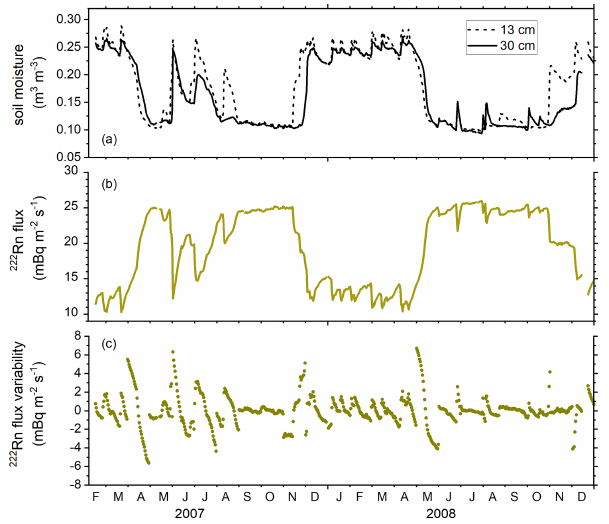
Figure A1. (a) Daily variations of measured soil moisture at the Grenzhof site near Heidelberg at depths of 13 and 30cm. The hy- pothetical 222 Rn flux estimated from the soil moisture (and tem- perature) variability is shown in (b) , while the day-to-day variabil- ity around the corresponding monthly means of the 222 Rn flux is shown in (c) . The average variability corresponds to 10% around the monthly mean